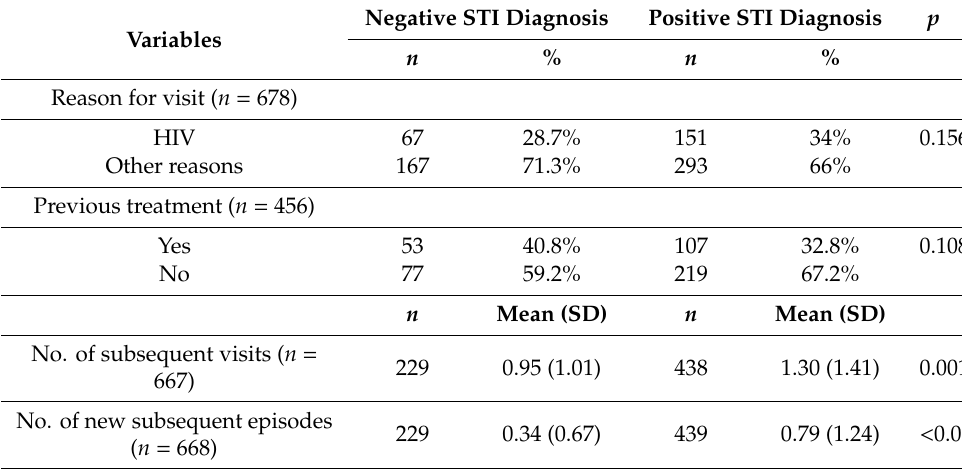
Table 2. STI diagnosis vs. healthcare